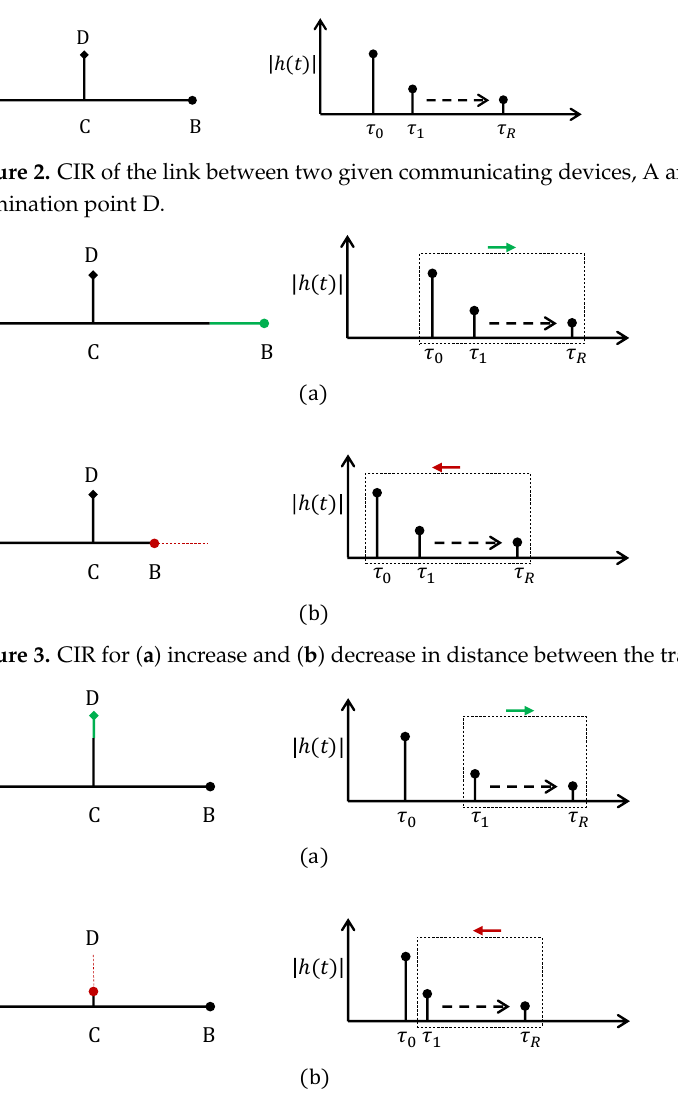
Figure 4. Response of path delay impulses for ( a ) increase and ( b ) decrease in the branch length.